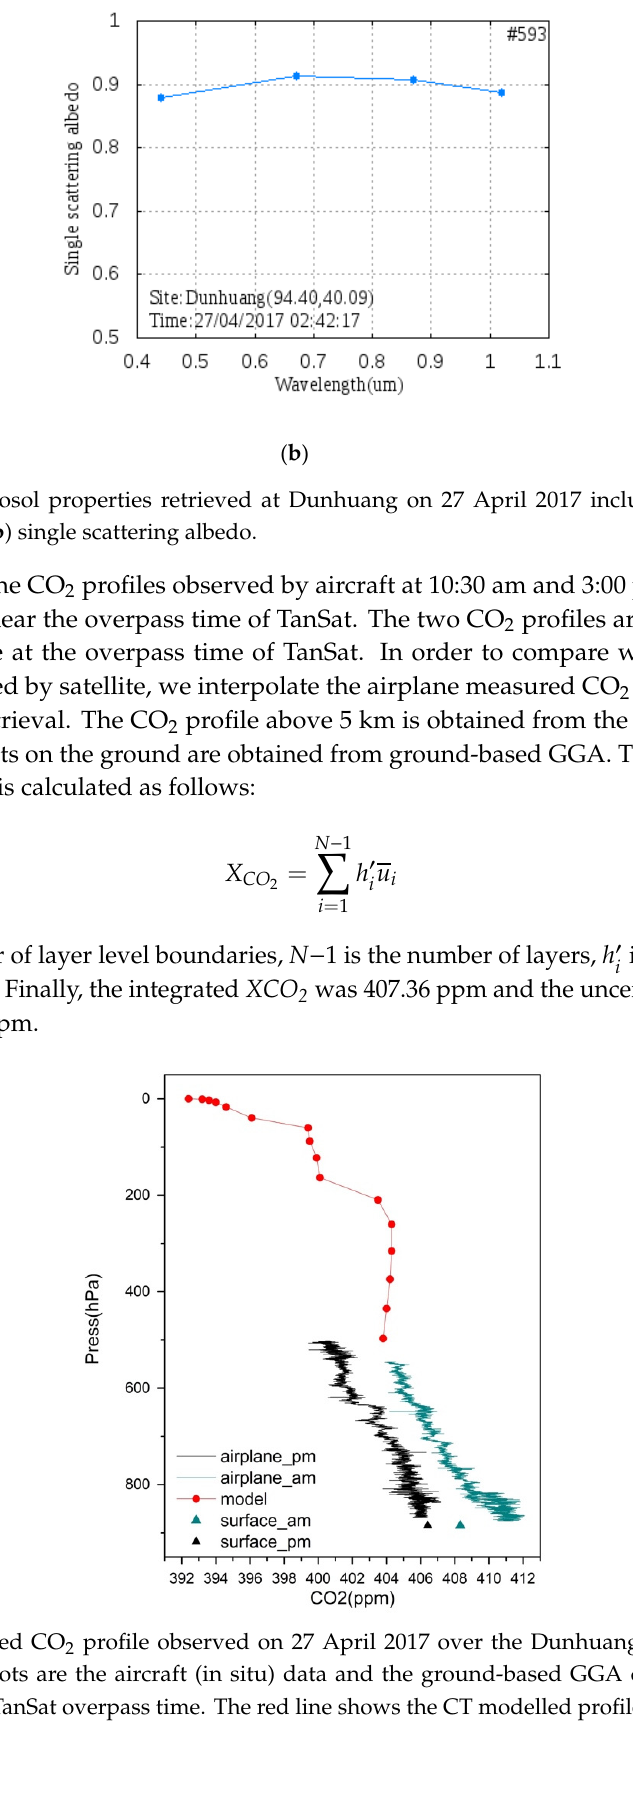
Figure 9. The retrieved XCO 2 of all 9 TanSat footprints over Dunhuang on 27 April 2017. The following two cases show the XCO 2 retrievals over the ground-based FTS in Beijing (40.05° N, 116.28° E) on 4 and 31 May 2018, as shown in Figure 10. The AODs at 500 nm near the satellite overpass time on these two days are 0.63 and 0.20 respectively. The comparison of XCO 2 retrieval accuracy of these two days can indicate how the ACOS algorithm performs for the aerosol scattering correction. The XCO 2 observed by ground-based FTS is 415.50 ppm and 412.21 ppm on 4 and 31 May, respectively. The average XCO 2 of all footprints on 4 May is 413.26 ppm. The average bias and variance are − 2.24 ppm and 1.65 ppm. The average XCO 2 of each footprint ranges between 413.36 ppm and 413.75 ppm. Except for the significantly higher variance of footprint-6 (3.3 ppm), the variances of other footprints range between 1.02 and 2.31 ppm. On 31 May, the average XCO 2 of all footprints is 412.06 ppm, and the average variance is 2.13 ppm. The bias from ground-based measurement is − 0.15 ppm. The average XCO 2 of each footprint is between 411.79 ppm and 412.29 ppm. Except for the significantly higher variance of footprint-6 (3.58 ppm), the variance of other footprints range between 1.77 ppm and 2.54 ppm.